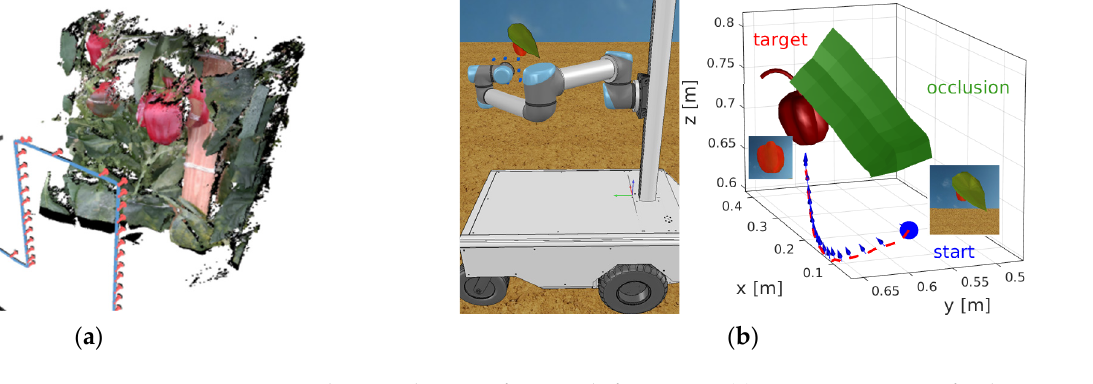
Figure 11. Active multi-view detection for a single fruit target. ( a ) Scanning trajectory for determining the pepper fruit from plants (Photo: Reprinted with permission from Ref. [95]. 2017, Lehnert C.); ( b ) multi-perspective visual observation for occluded fruit (Photo: Reprinted with permission from Ref. [99]. 2018, Lehnert